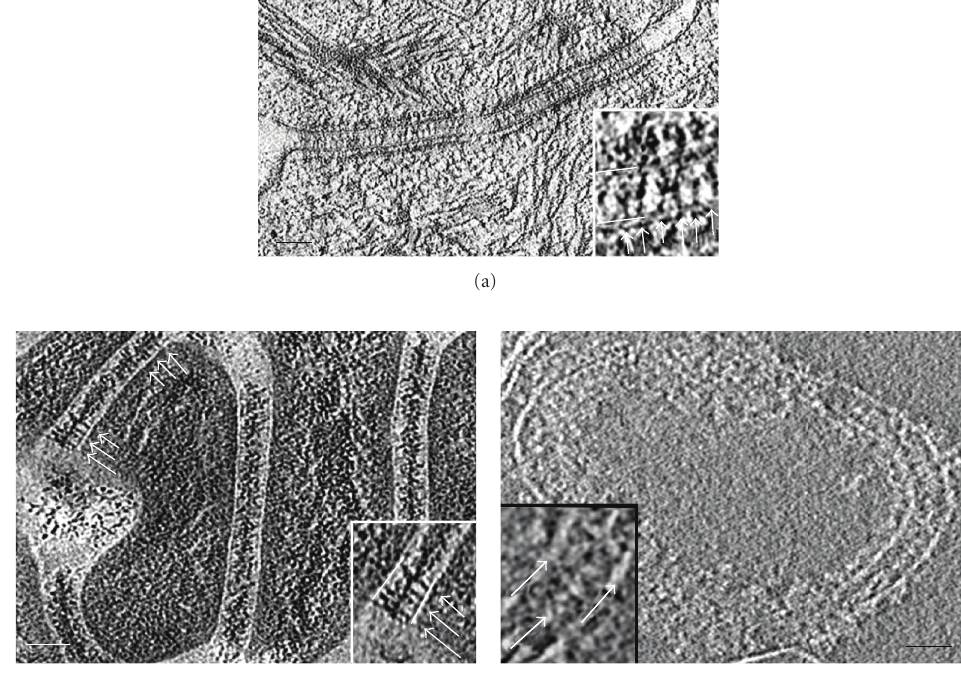
Figure 5: Electron tomography of desmosomes from freeze-substituted resin-embedded epidermis of newborn mouse (a). Cadherin densities can be seen spanning the extracellular space and individual intermediate filaments projecting towards the cell membrane in the cytoplasm. The inset provides a magnified view of the irregular nature of cadherin association creating the dense mid-line. (b) In the cow snout stratum spinosium , cadherin densities can be seen spanning the extracellular space but the density of cadherin molecules is appreciably much higher. The dense mid-line can be observed by viewing the slice at a glancing angle however, in some areas, the irregular nature of cadherin association is visible (arrows) and can be seen magnified in the inset. Membranes are highlighted by lines and the cadherins by arrows in both a and b. (c) Cryoelectron tomography of isolated desmosomes in the frozen unstained state. A slice from a tomogram showing a desmosome which has curled up at the edge to provide a direct view of cadherin organisation. The two bilayers are clearly visible and a midline composed of globular densities can be seen bisecting the extracellular space (inset). These globular densities (arrow) probably correspond to the groups of cadherin molecules seen previously in freeze-substituted samples. Reproduced with permission from, [23] the Biochemical Society (http://www.biochemsoctrans.org/). Scale bars 50